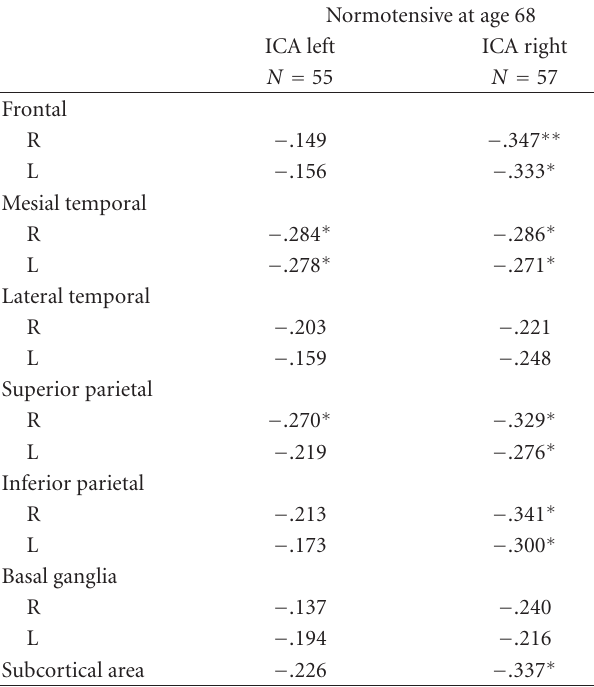
Table 3: Partial correlation coe ffi cients between peak systolic velocity in right/left ICA and cerebral blood flow, controlled for the grade of carotid stenosis